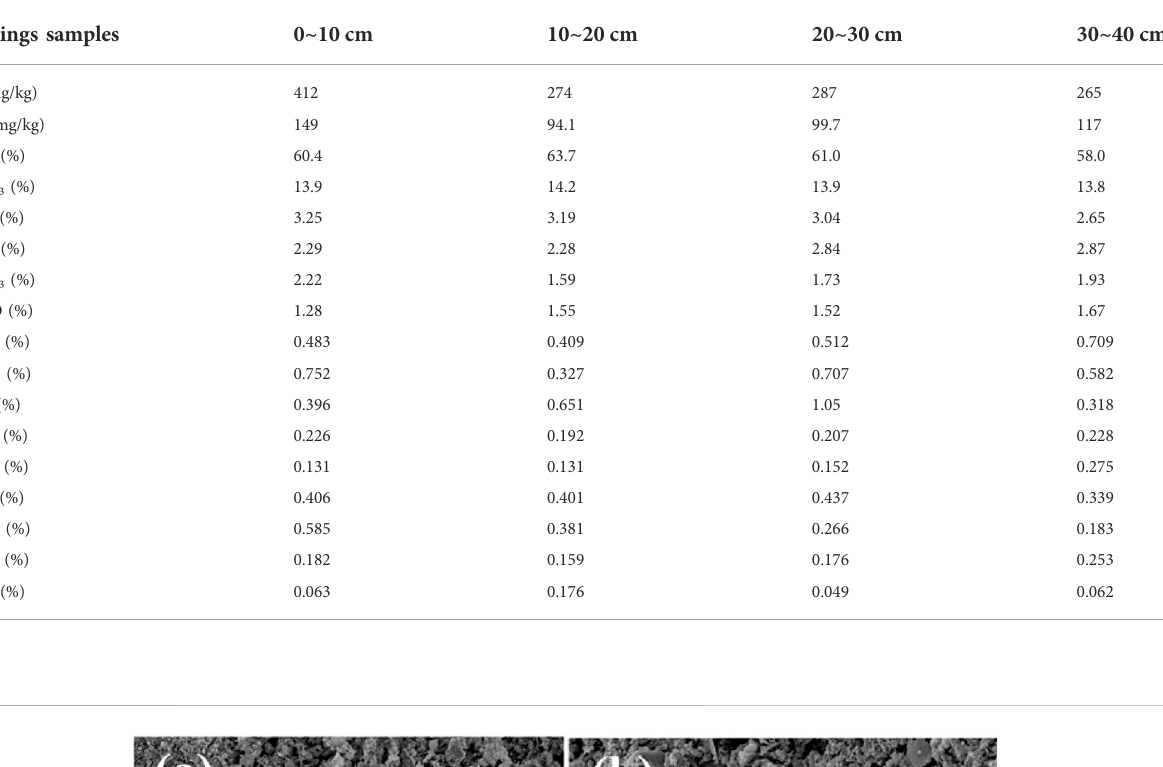
TABLE 2 XRF analysis results of uranium tailings.